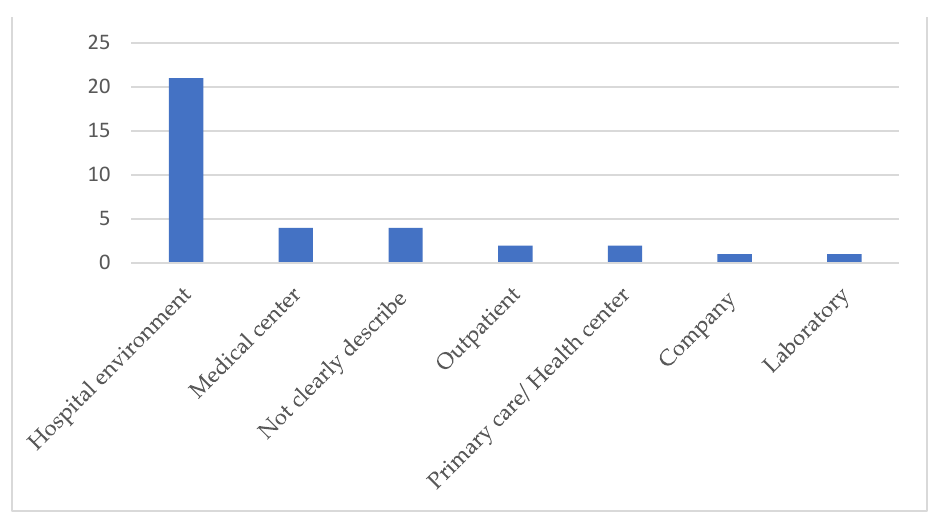
Figure 4. Locations where tools were applied.